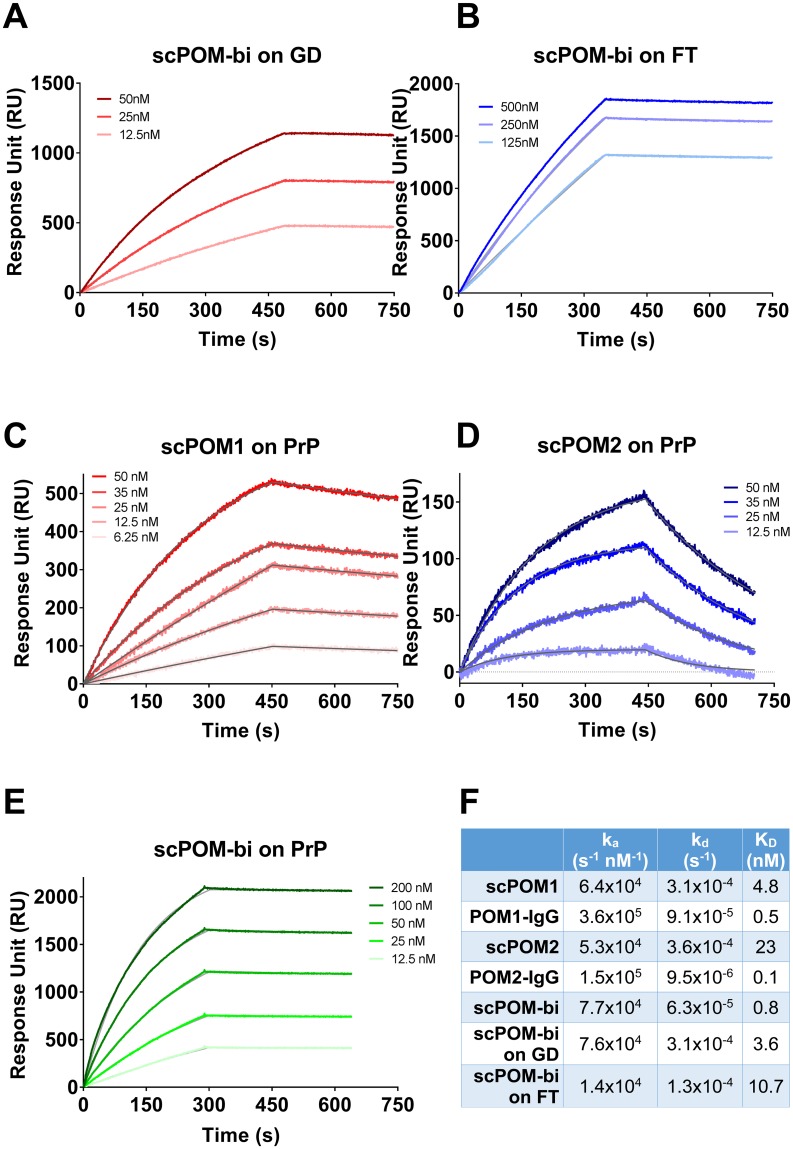
The bispecific antibody scPOM-bi binds simultaneously to GD and FT of PrP with high affinity.SPR sensorgrams for binding of scPOM-bi to truncated PrP constructs lacking FT (A) or GD (B) indicate that both antigen binding sites of scPOM-bi correctly engage their target. The bispecific antibody (E) had a stronger affinity than its individual components (C-D) due to avidity resulting in a slower dissociation. The fitting of the experimental data used to calculate the binding constants is in grey. Values for the above plus the full IgG versions of POM1 and POM2 are summarized in (F).